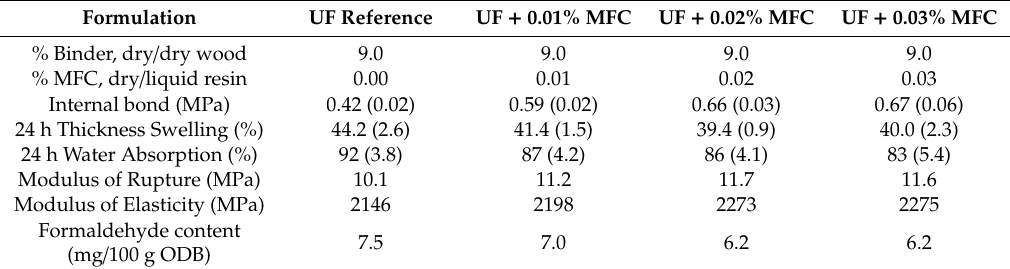
Table 5. Particleboard panels analysis, MFC 2% increasing levels, resin stable, Approach 3.